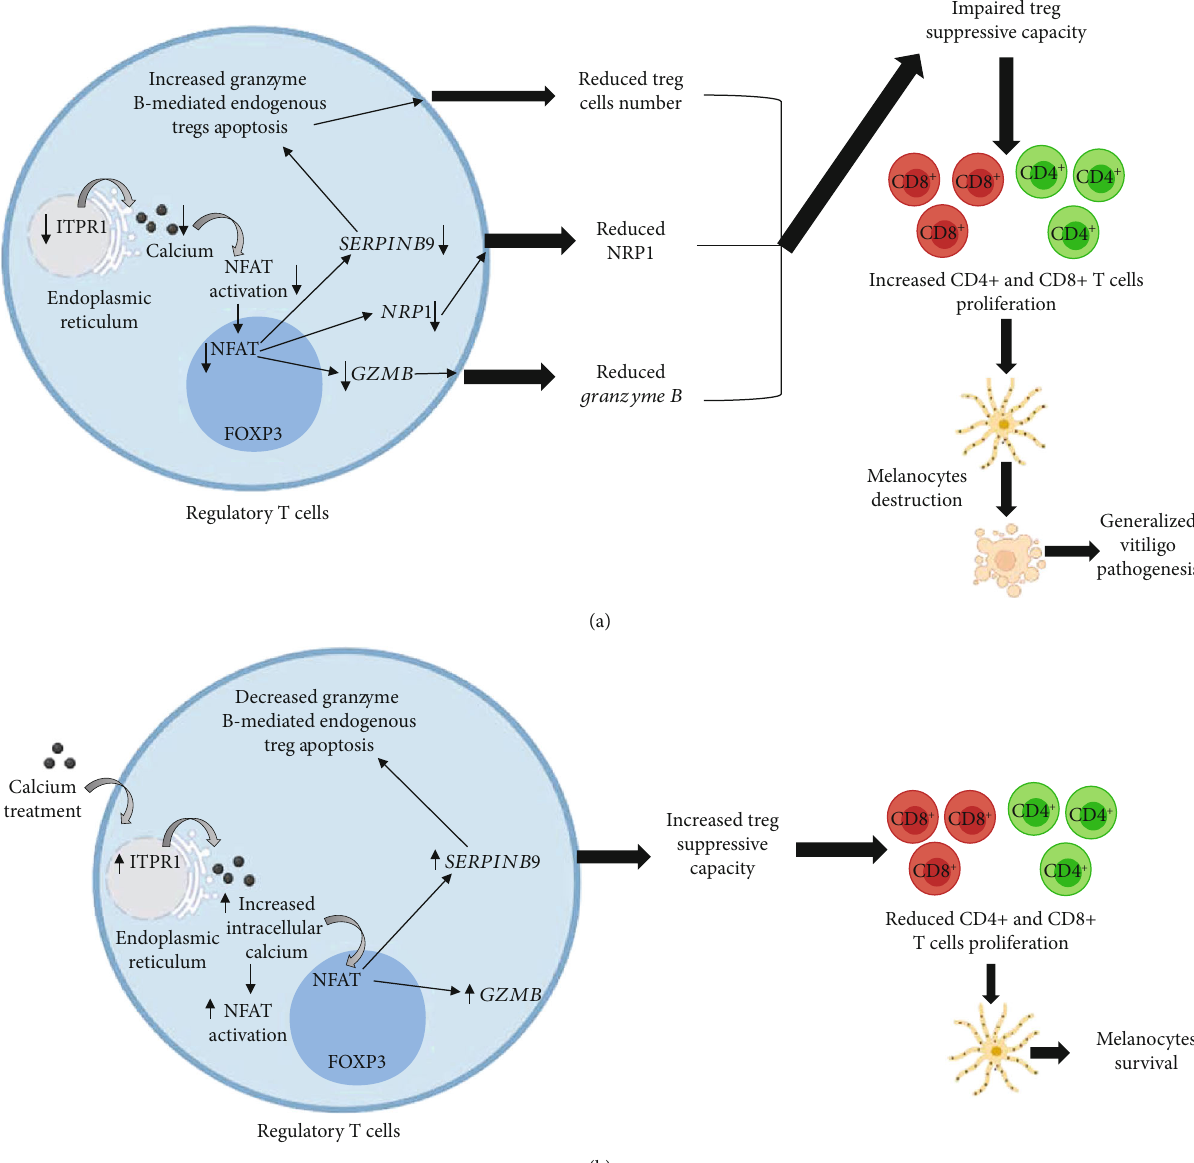
Figure 6: Role of GZMB , NRP1 , SERPINB9 , and ITPR1 transcripts in GV pathogenesis. (a) The decreased ITPR1 transcripts could lead to impaired calcium-NFAT signalling pathway, which might result in decreased GZMB and NRP1 transcripts. Further, the decreased SERPINB9 transcripts may result in increased granzyme B-mediated endogenous apoptosis of Tregs. Overall, the decreased GZMB , NRP1 , SERPINB9 , and ITPR1 transcripts result into decreased Treg suppressive capacity, which could lead to unchecked CD4 + and CD8 + T cells and thereby results into melanocytes ’ destruction contributing to GV pathogenesis, progression, and severity. (b) Upon calcium treatment, ITPR1 mRNA expression is increased which may lead to intracellular Treg calcium in fl ux and calcium-NFAT signalling pathway, thereby results into increased GZMB and SERPINB9 transcripts, leading to increased Treg suppressive capacity. The increased Treg suppressive capacity controls the CD8 + and CD4 + T cells proliferation and IFN- γ production and thereby contributes to melanocytes